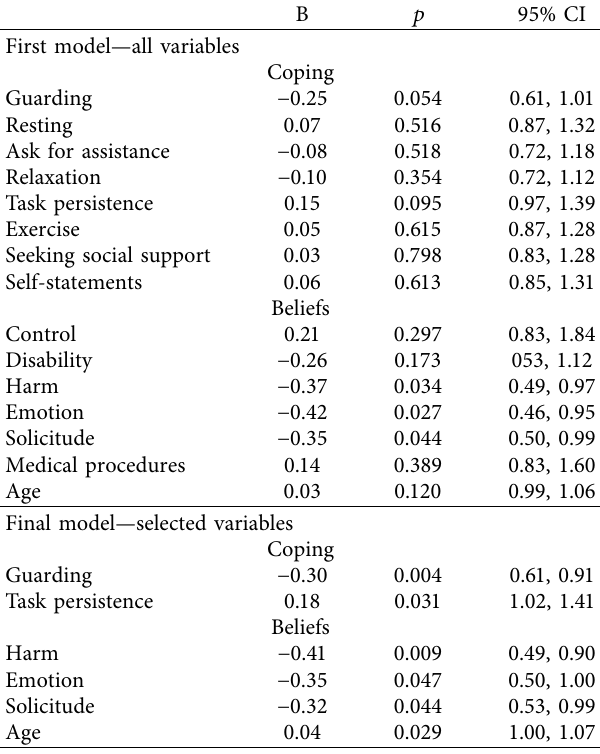
Table 2: The first step and final model in the backward binary logistic regression predicting cluster membership.